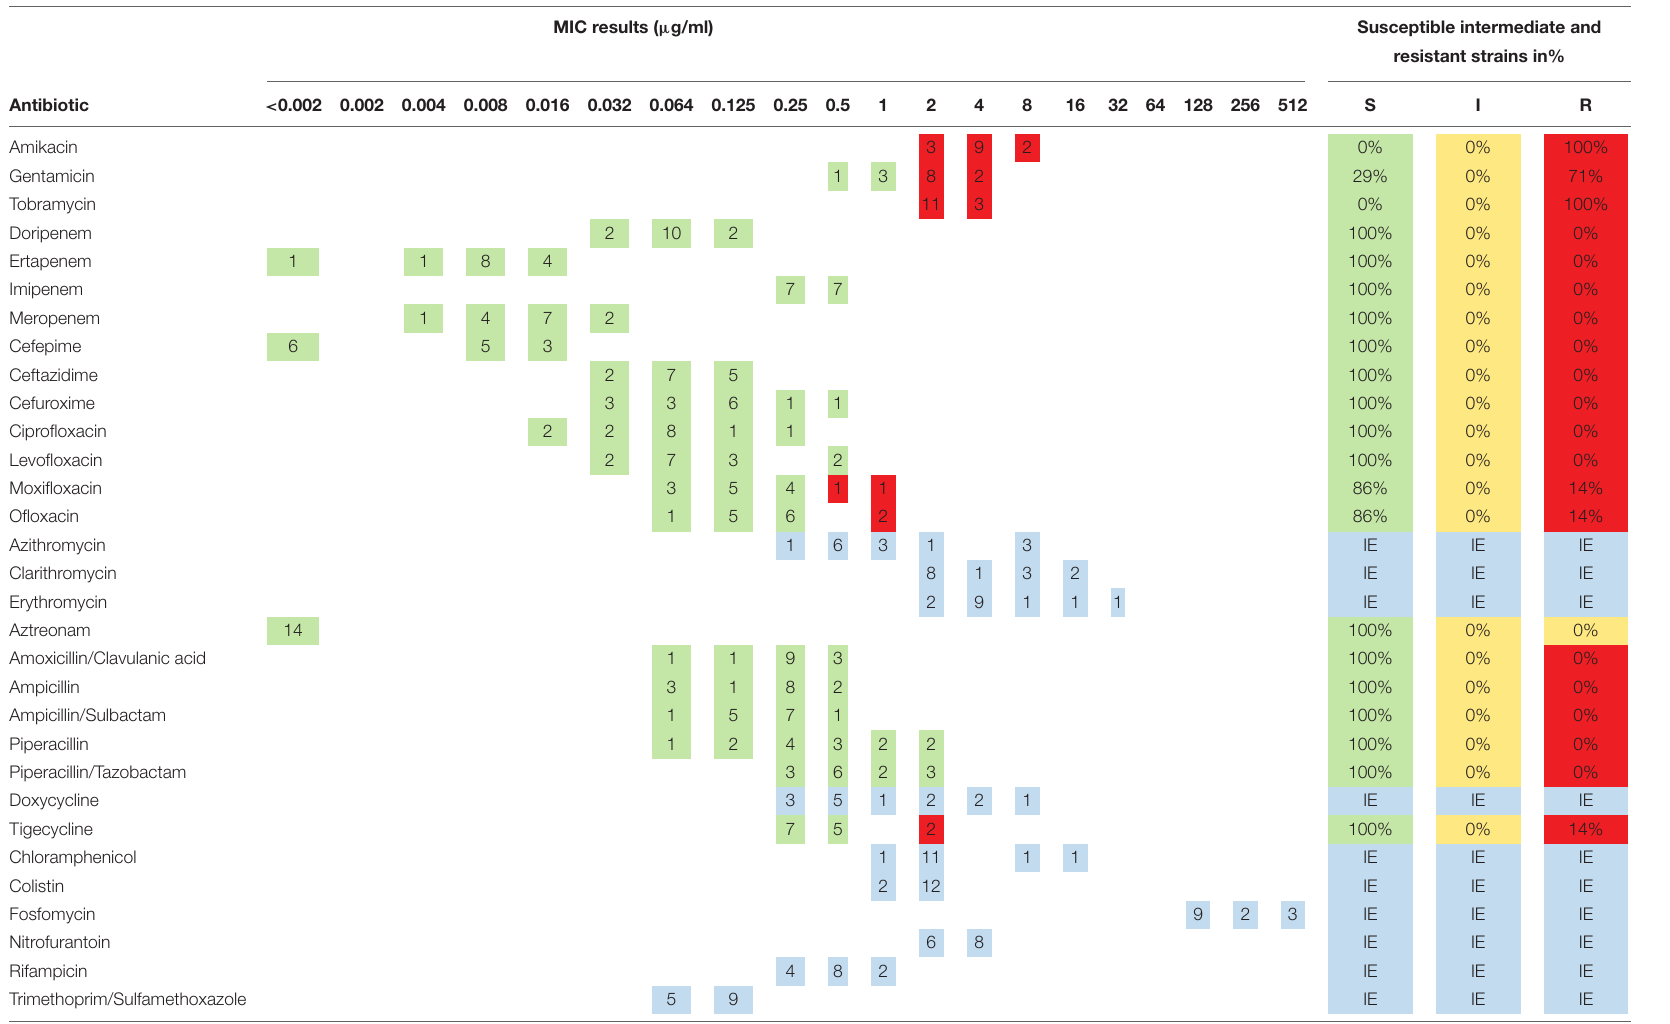
TABLE 4 | Minimum inhibitory concentration (MIC) distribution of 14 W. chitiniclastica strains.